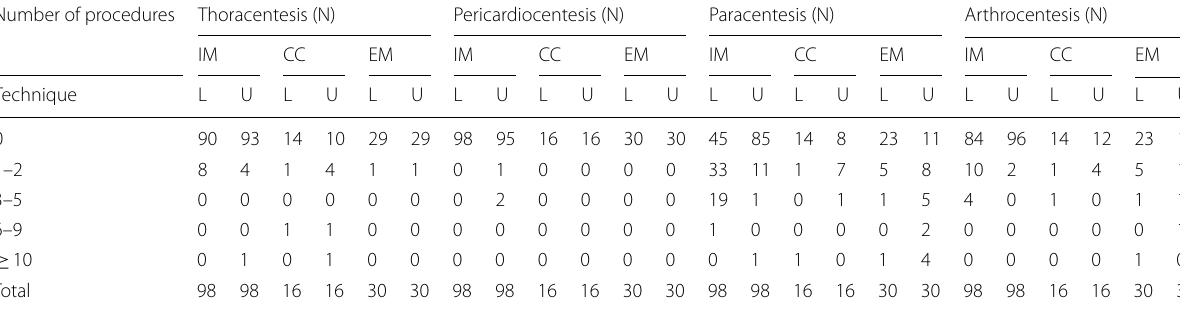
Data stratified by procedure, specialty, and technique (i.e. L landmark, U ultrasound-guided) are presented as frequency. Abbreviations. CC critical care, EM emergency medicine, IM internal medicine, L landmark, N number of respondents, U ultrasound-guided